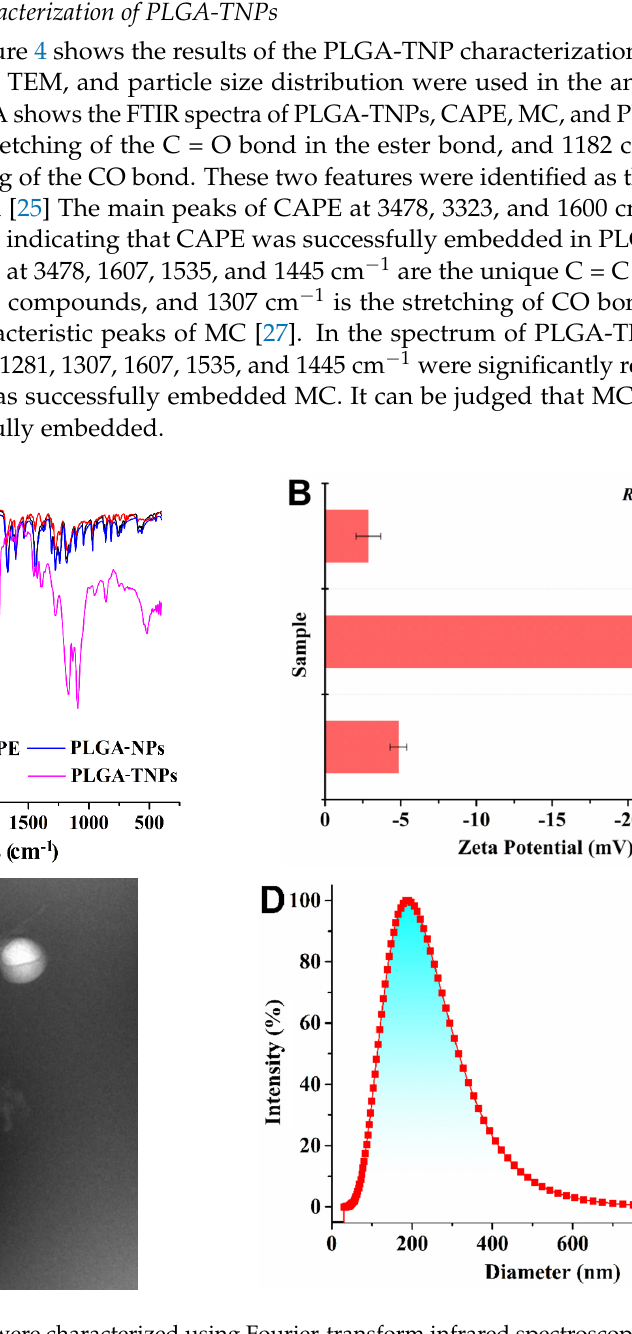
Figure 4. The prepared PLGA-TNPs were characterized using Fourier-transform infrared spectroscopy ( A ), zeta potential analysis ( B ), particle size distribution ( C ), and transmission electron microscopy ( D ).